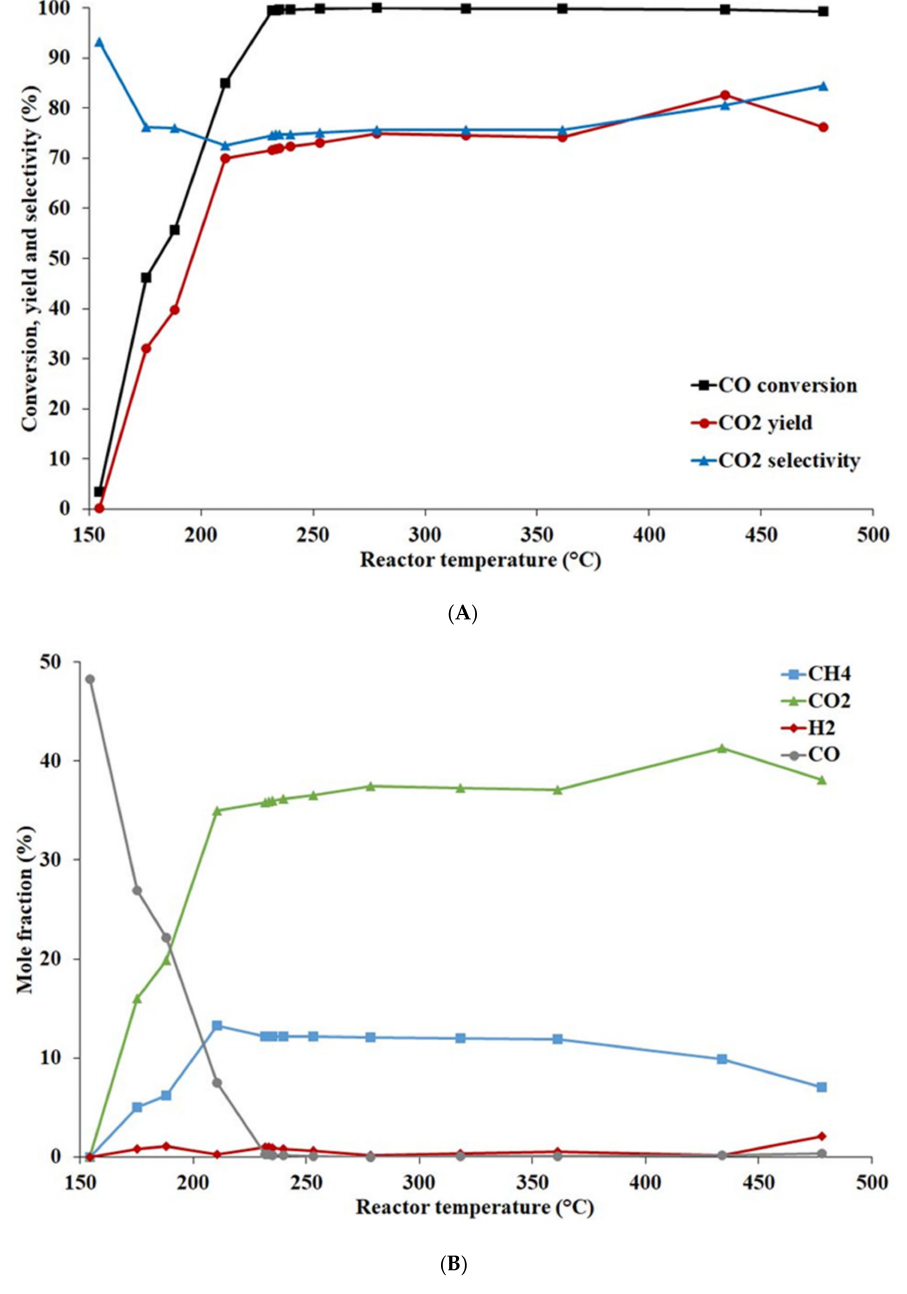
Figure 4. Catalytic tests with feed gas mixture 1 (50 mole% CO and 50 mole% N 2 ) at pressure 4 MPa over a commercial Ni-based catalyst: ( A )—CO conversion, CO 2 yield, and CO 2 selectivity; ( B )—composition of the produced